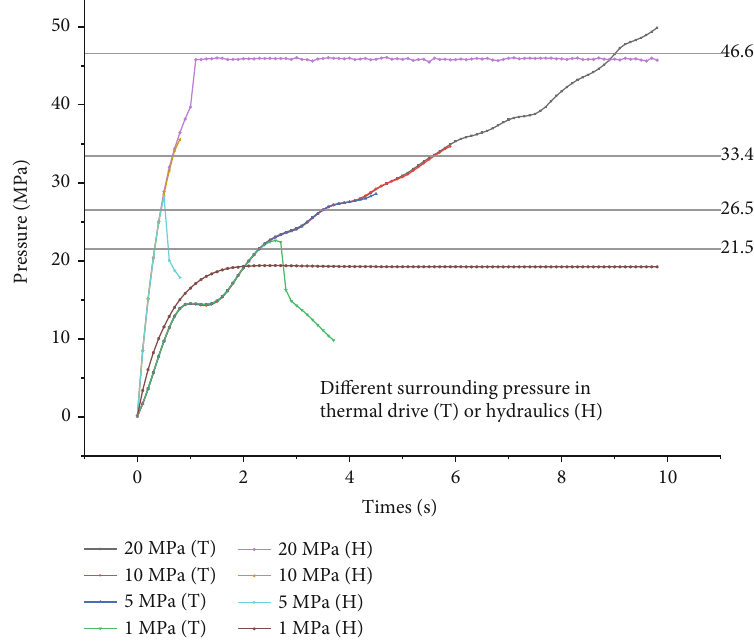
Figure 20: Pressure curves for thermally driven fracturing and hydraulic fracturing under di ff erent boundary pressure conditions when the rock tensile strength is